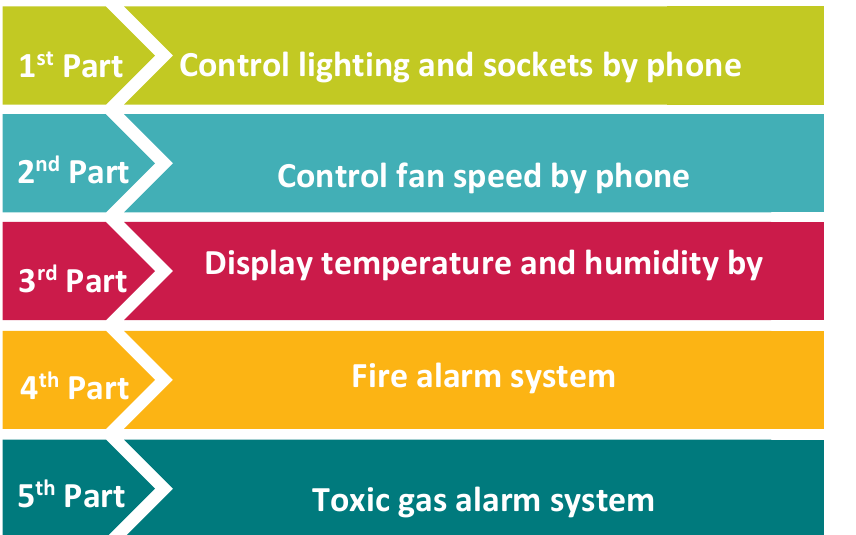
Figure 3. The five developed smart home applications in this paper.